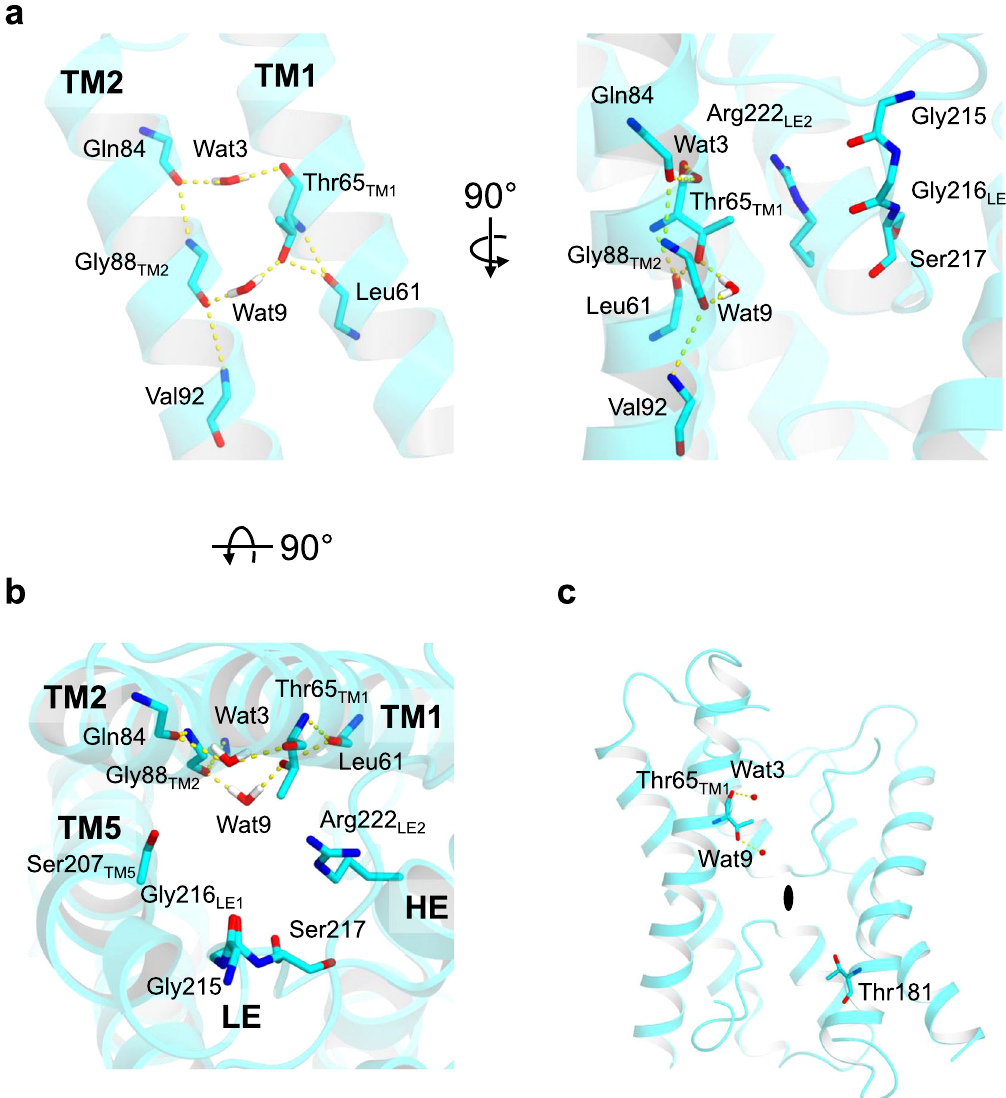
Fig. 4 Unique water molecules and two Thr residues in the Lsi1 structure. Hydrogen bonding interactions between the two water molecules comprising SF (Wat3 and Wat9) and TMs (TM1 and TM2) are shown with view directions facing the channel ( a ) or from the extracellular side ( b ). c A panel is showing the positions of Thr65 and Thr181. Hydrogen bond interactions that make the oxygen atoms of the waters pointing towards the channel are shown in yellow